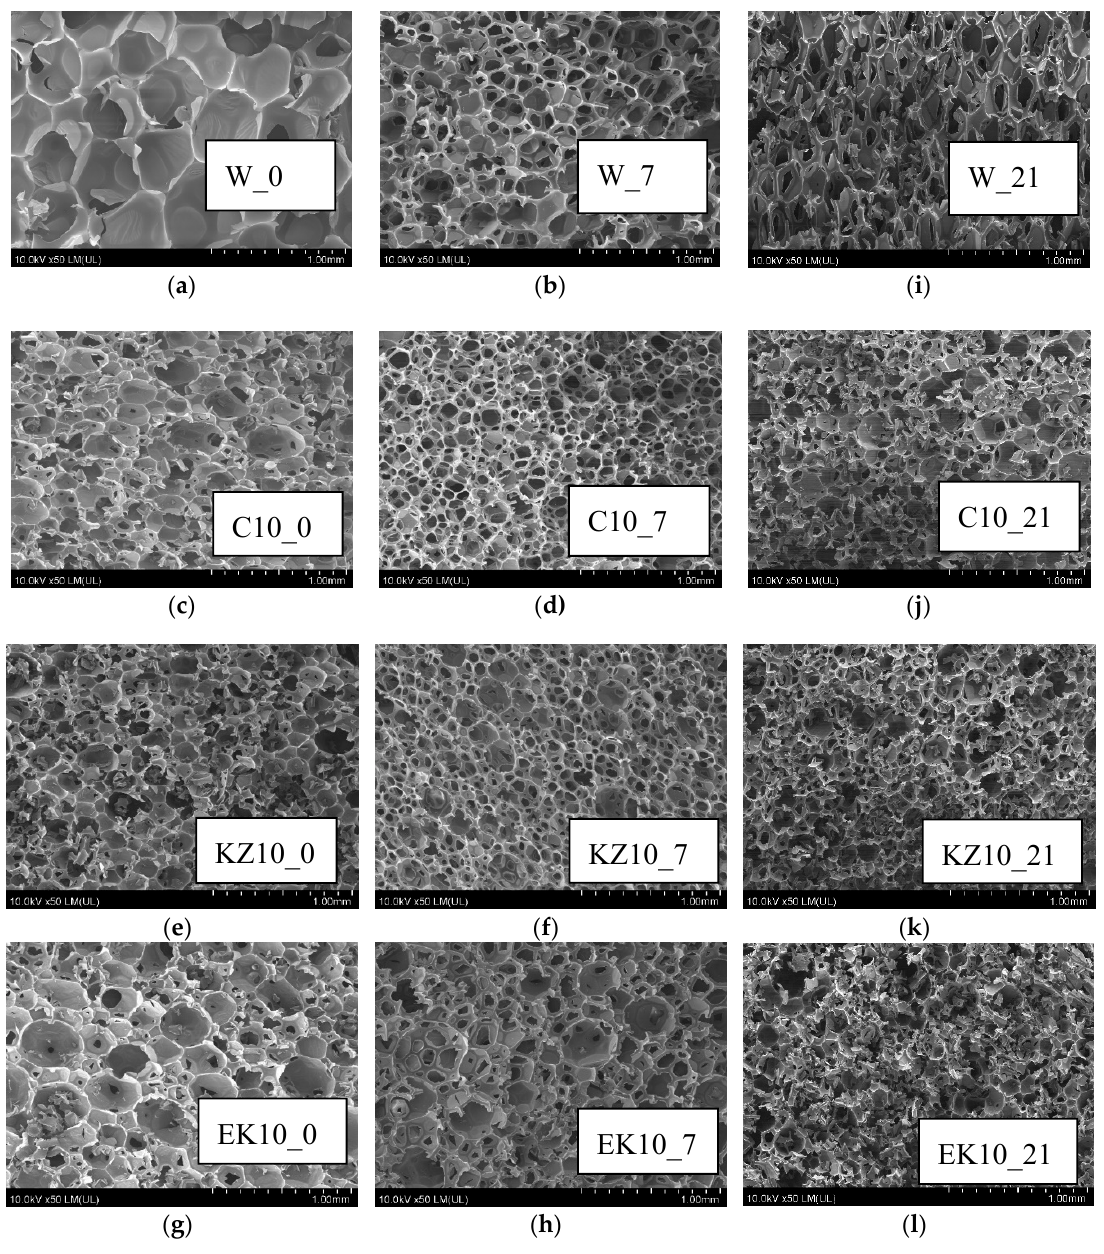
Figure 6. SEM micrographs of foams: ( a ) W_0, ( b ) W_7; ( c ) C10_0; ( d ) C10_7; ( e ) KZ10_0t; ( f ) KZ10_7;